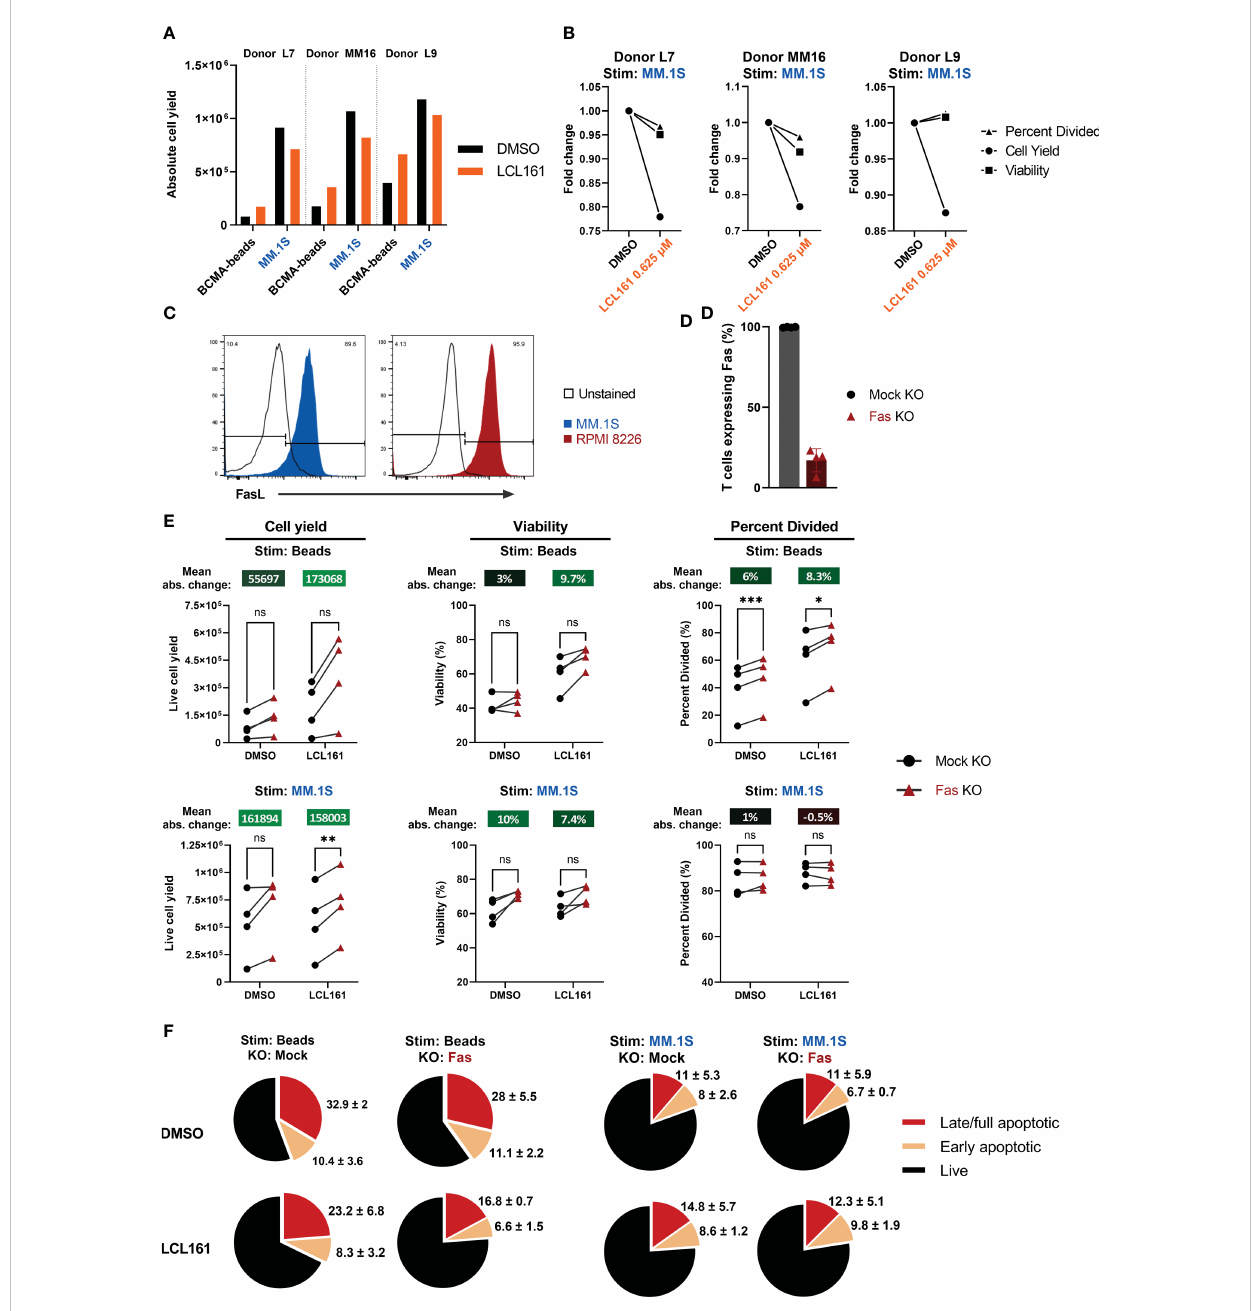
FIGURE 4 LCL161 does not enhance TAC T cell survival and proliferation when co-cultured with myeloma cells in vitro and is independent of Fas. (A-B) Thawed and rested cryopreserved BCMA TAC T cells were stimulated 1:1 with MM.1S tumor cells or BCMA-coated microbeads in the presence of 0.625 m M LCL161 for 96 hrs. Absolute cell count was enumerated using counting beads during fl ow cytometric analysis. The bead proliferation data displayed in (A) is shared in Figure 2B. (B) Proliferation metrics from TAC T cells stimulated with MM.1S cells were normalized to the vehicle control. (C) Cultured MM.1S and RPMI 8226 myeloma cells were stained for FasL expression and analyzed by fl ow cytometry. (D – F) BCMA TAC T cells were cultured as normal and edited on day 3 with Fas multi-guide or negative control gRNA/Cas9 RNP by Neon electroporation. T cells were